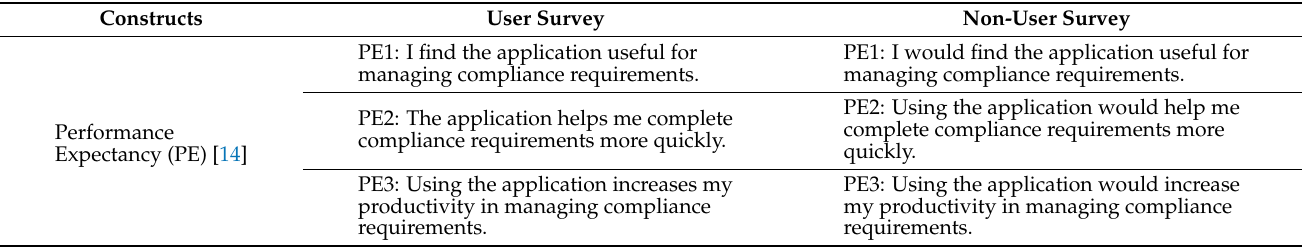
Table A5. Non-user focus